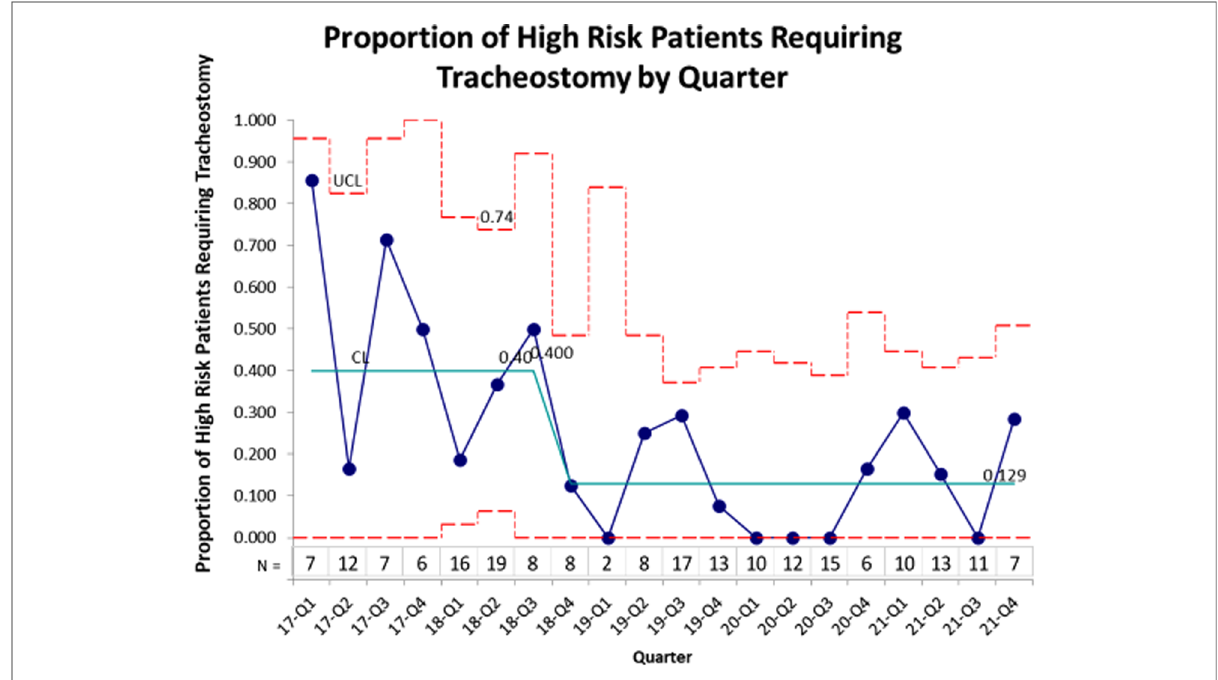
FIGURE 1 Proportion of patients at high risk for severe BPD requiring tracheostomy over